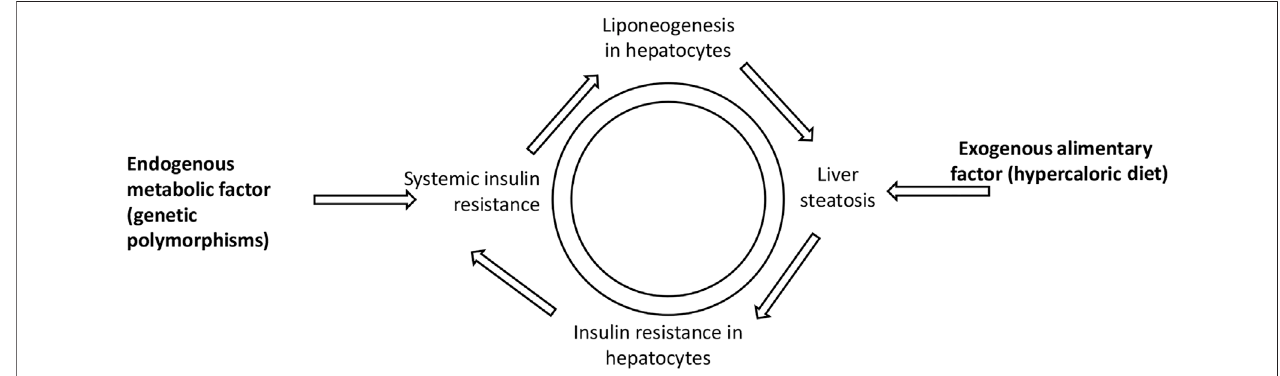
FIGURE 1 | Vicious circle illustrating liver steatosis and prediabetes interconnection. Both exogenous alimentary factor (hypercaloric diet) and endogenous metabolic factor (genetic polymorphisms) may lead to systemic insulin resistance and liver steatosis.